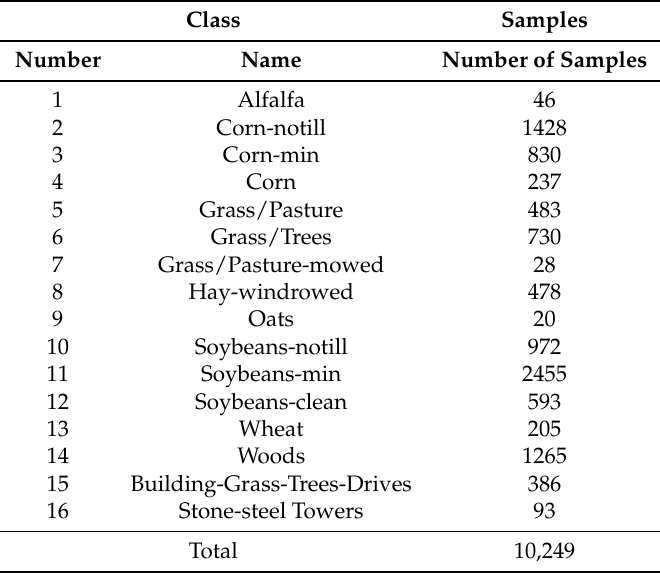
Figure 5. Color coding for the Indian Pines data set. Table 2. Sample size for the Indian Pines